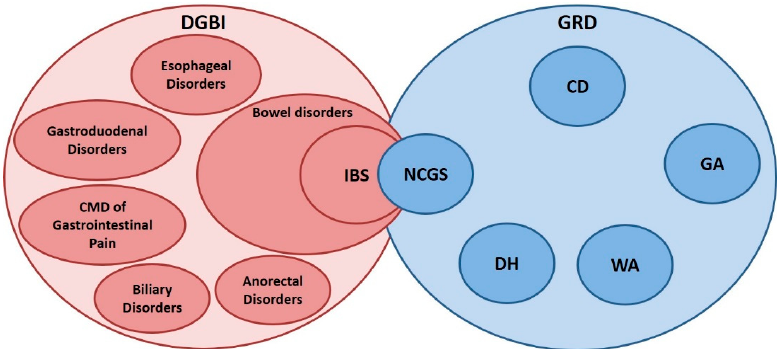
Figure 3. The overlap between IBS and NCGS. Disorders of gut–brain interaction (DGBI) include several disorders [95] affecting the gastrointestinal tract in which the gut–brain axis has a role in symptom generation. Among gluten-related disorders (GRD), NCGS is completely distinct from the other conditions including celiac disease (CD), gluten ataxia (GA), dermatitis herpetiform (DH), and wheat allergy (WA). NCGS is partially overlapped to IBS for symptoms, although there are also some differences. NCGS is characterized by a greater incidence, although not to the same extent as CD, of anemia, weight loss, low body mass index, atopy, osteopenia and osteoporosis compared to IBS. CMD of Gastrointestinal Pain: Centrally Mediated Disorders of Gastrointestinal Pain.